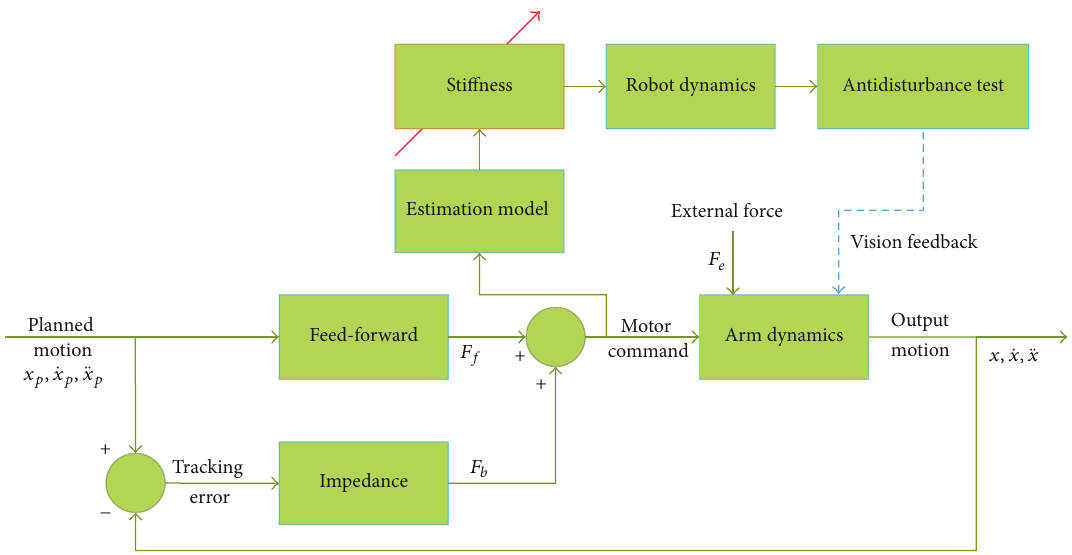
Figure 1: Profile of arm control model and stiffness transfer from human to robot for antidisturbance test [34]: 𝑥 𝑝 , ̇𝑥 𝑝 , ̈𝑥 𝑝 are planned posi- tion, velocity, and acceleration, respectively. 𝐹 𝑓 is feed-forward force. 𝐹 𝑏 is feedback force. 𝐹 𝑒 is the external force. 𝑥 , ̇𝑥 , ̈𝑥 are output position, velocity, and acceleration,